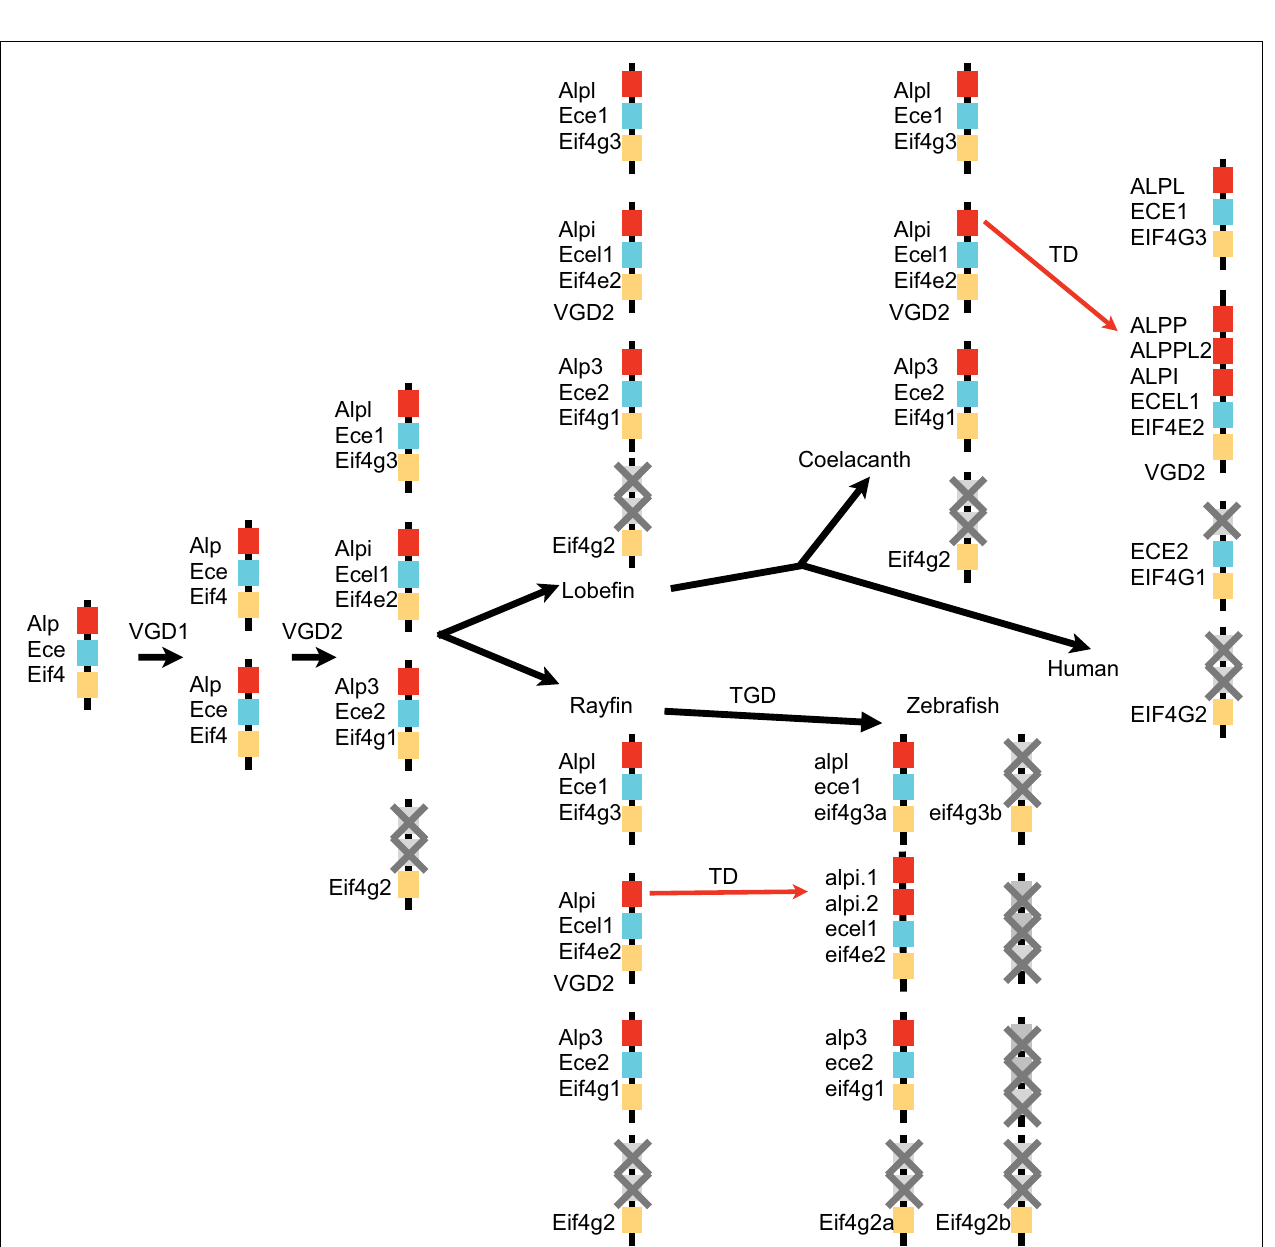
After the divergence of rayfin and lobefin bony fish lineages, the teleost genome duplication event (TGD) did not result in further extant Alp genes, but tandem duplications (TD) in the Alpi locus provided a number of separate Alp